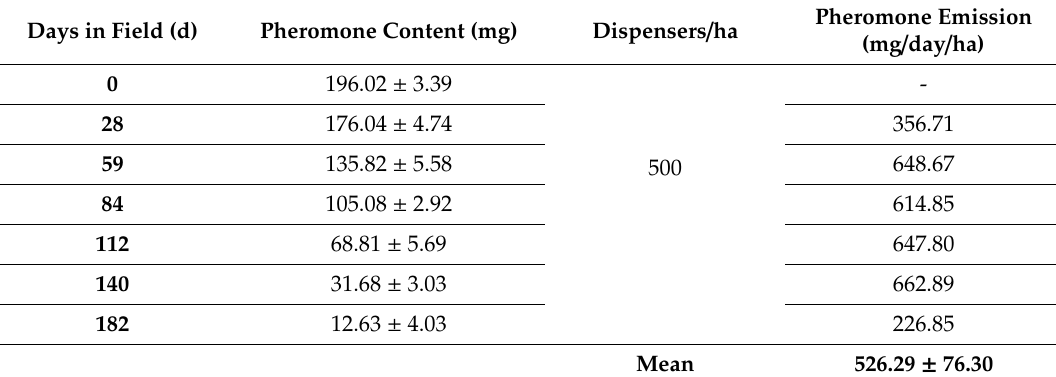
Figure 5. Pheromone release profile of Isonet L passive dispensers, as residual mean pheromone load (mg) contained in the dispensers vs. the time of field exposure (days). Release kinetics fitted the linear model given by the equation. Table 2. Isonet L passive dispensers aging. Residual means of pheromone content (mg) throughout the time in field (days). Point values of Figure 5 and the total mean of pheromone used (mg / day /